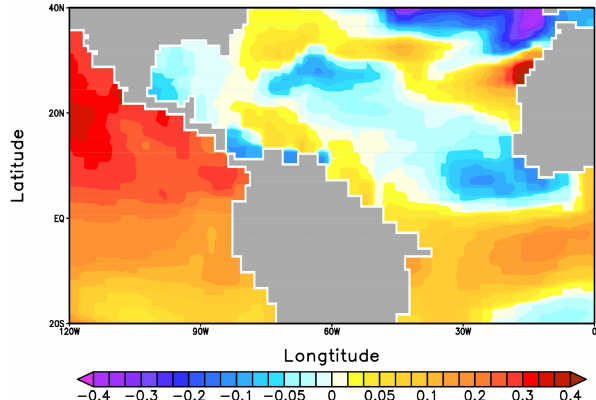
Fig. 12. Annual mean sea surface salinity anomaly (psu) at 6ka relative to pre-industrial, inferred from numerical simulations from the coupled general circulation model